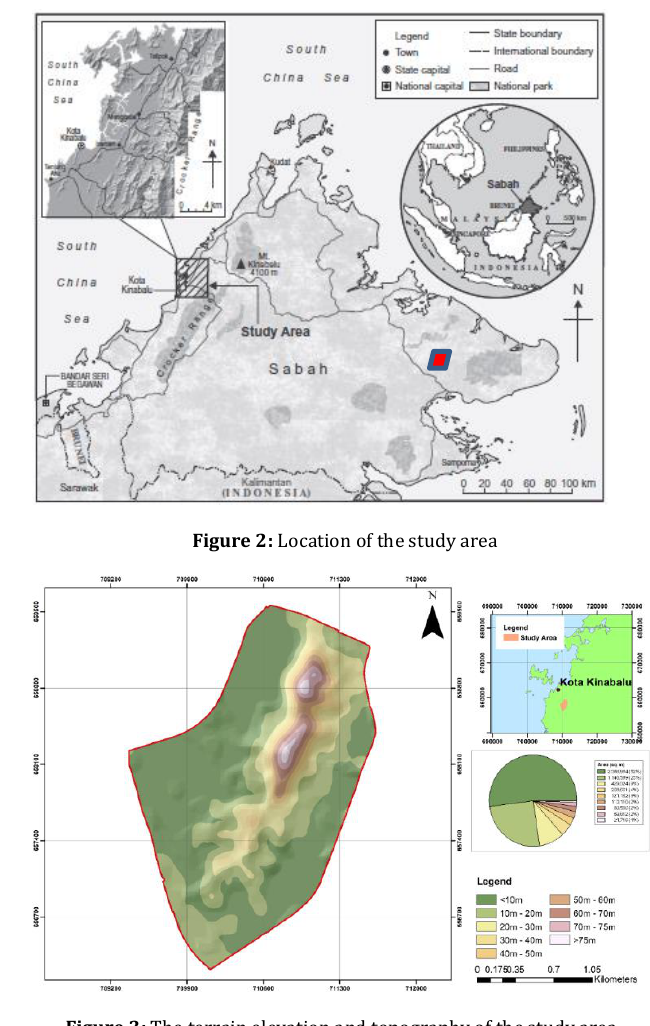
Figure 3: The terrain elevation and topography of the study